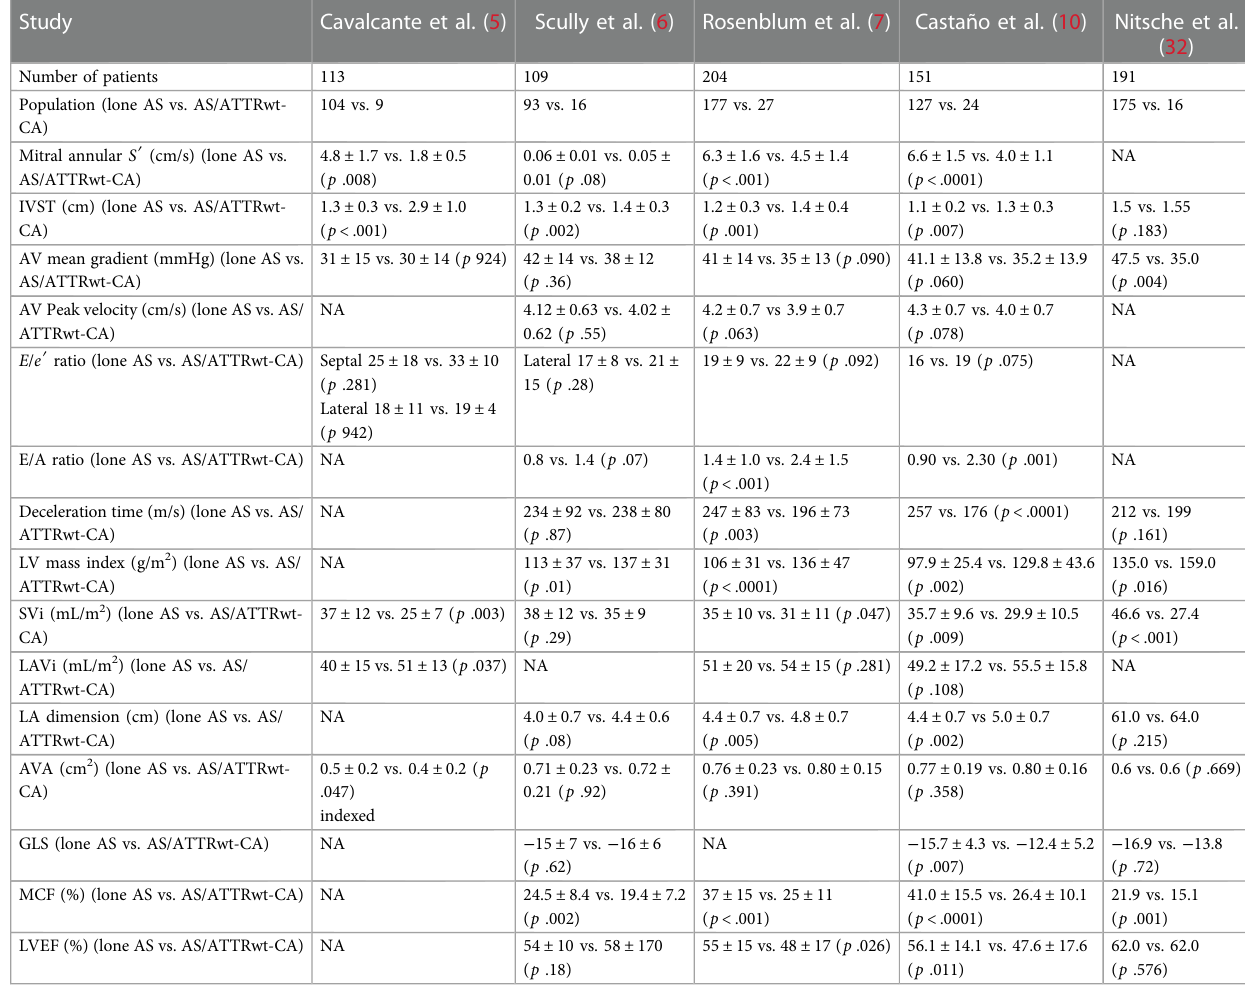
TABLE 3 Evaluation of the echocardiographic parameters of lone aortic stenosis vs. aortic stenosis associated with cardiac